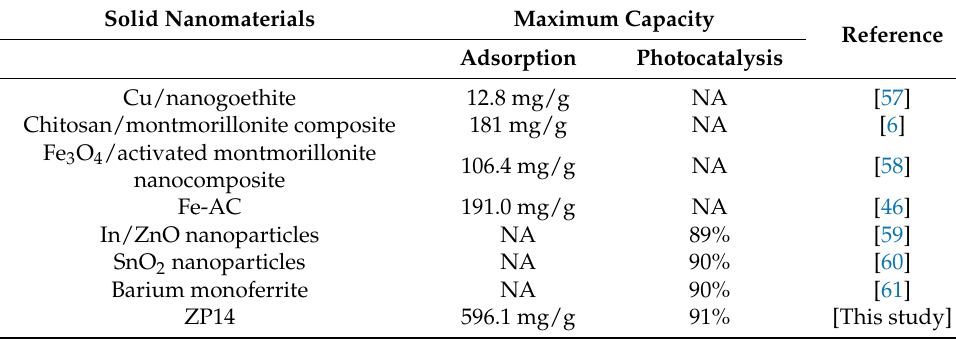
Table 3. Photocatalytic degradation and adsorption of MB using ZP14, compared with other solid